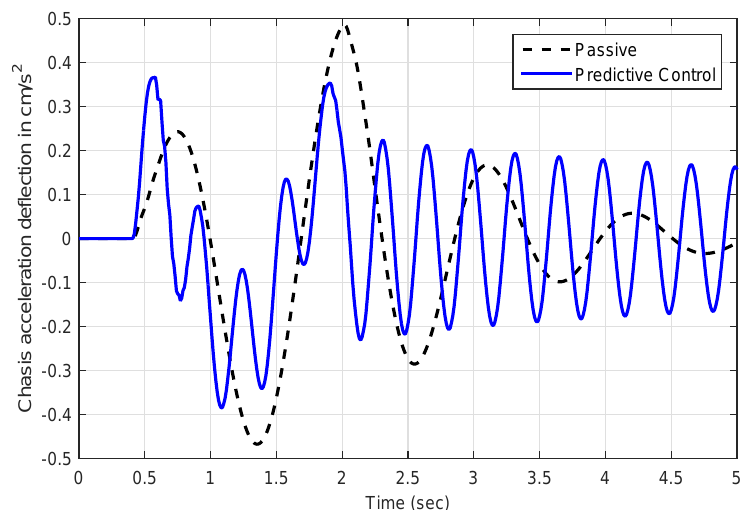
Figure 9. Chassis acceleration for the predictive controlled and passive suspension.